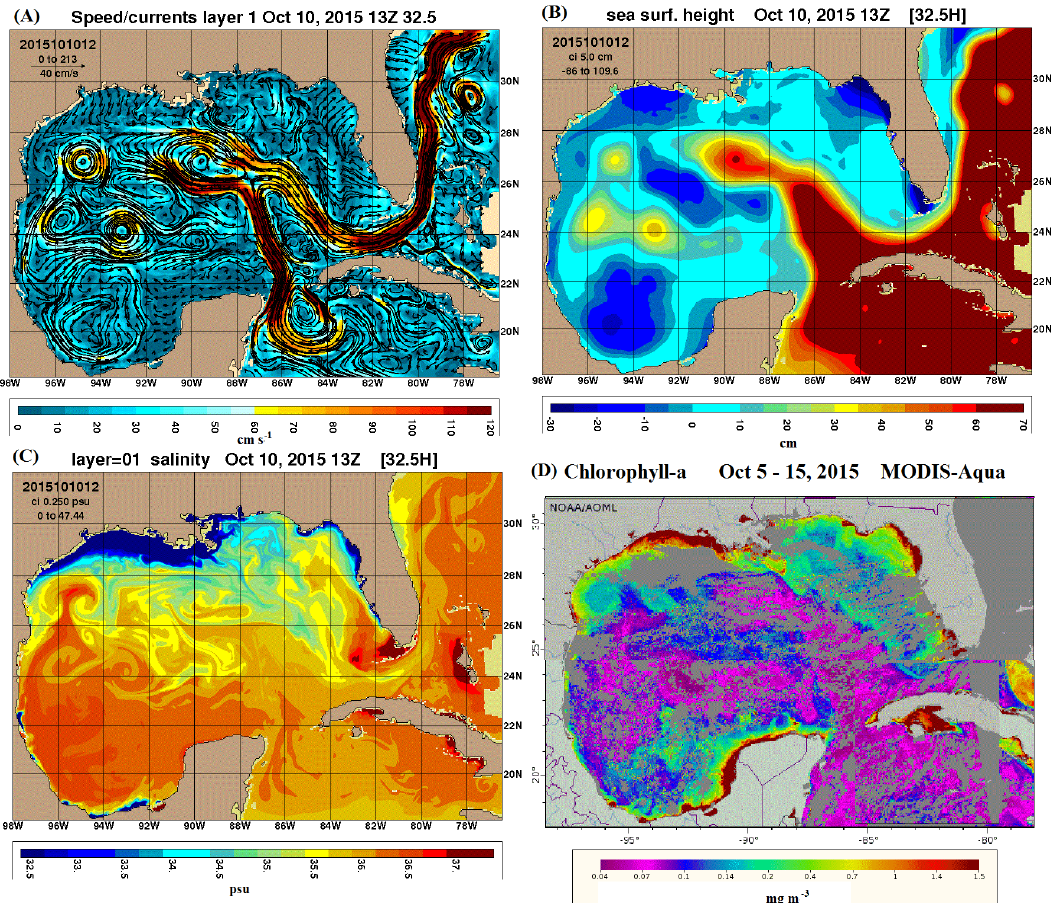
Figure 7. Synoptic views of the 10 October 2015 GoM surface layer ( A ) current velocity; ( B ) sea surface height; ( C ) salinity; and ( D ) Chl a concentration. Images ( A – C ) are daily model output from U.S. Navy